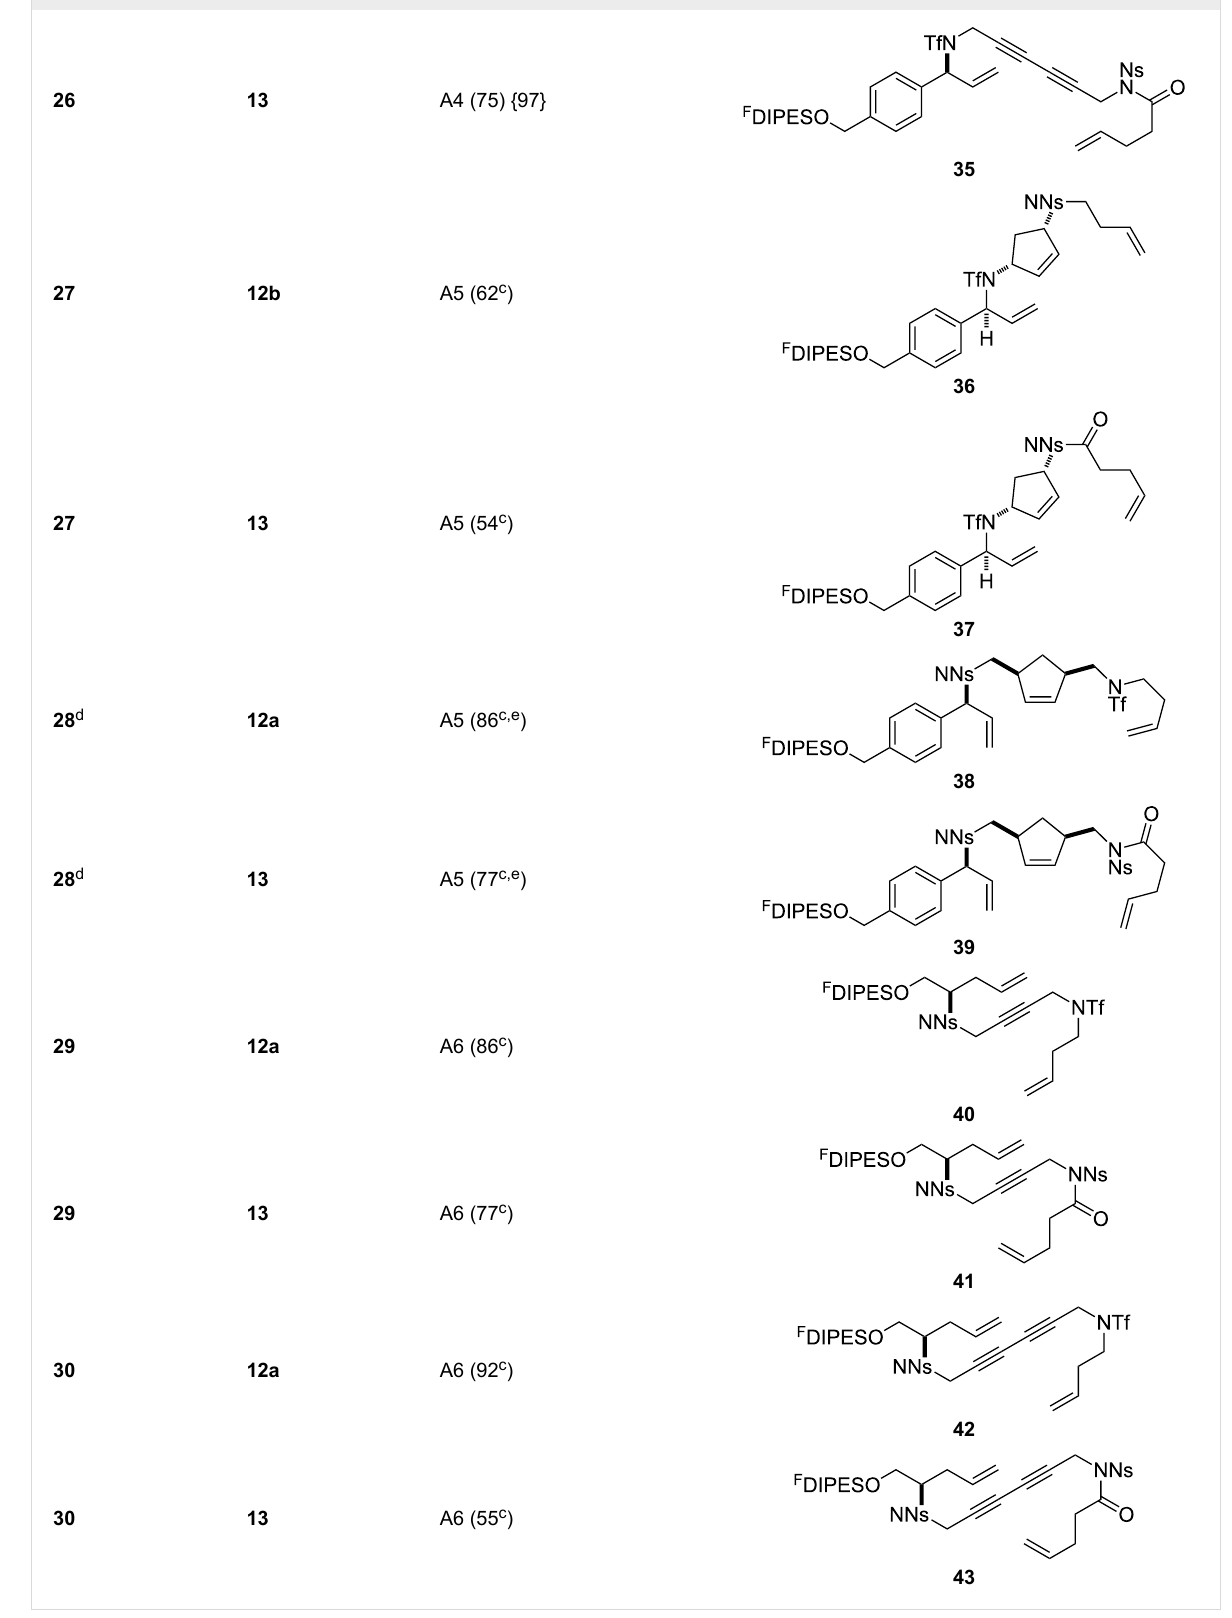
Table 2: Attachment of propagating building blocks to the fluorous-tagged initiating building blocks.